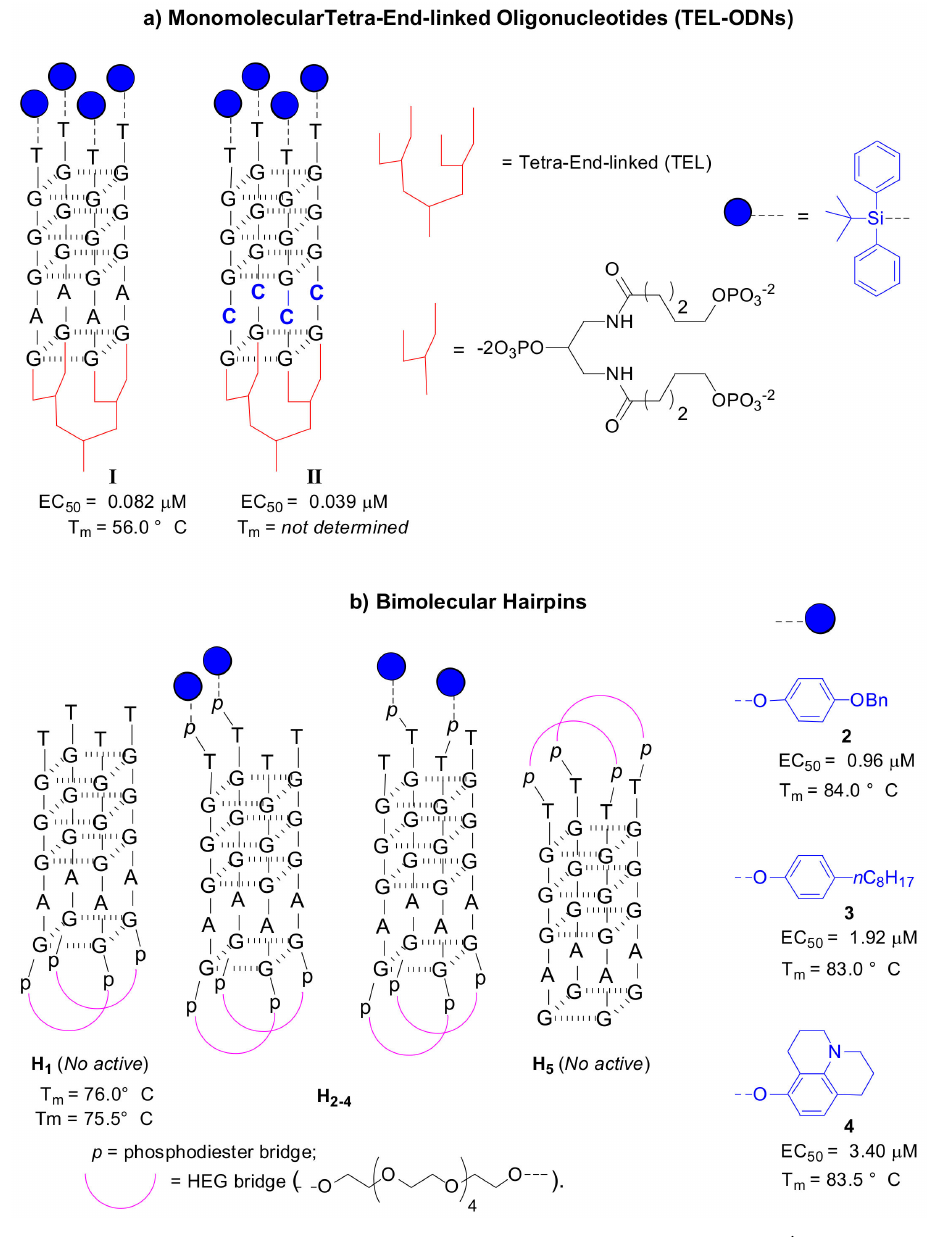
Figure 4. ( a ) G-quadruplex structures of monomolecular TEL-ODNs modified at 5 (cid:48) -end with TBDPS group ( I ) and the both 5 (cid:48) -end and internal modified TEL-G4 ( II ) with a cytosine that replaces the adenosine base of the Hotoda’s sequence [41,42], ( b ) Bimolecular G-quadruplex Hairpins with related anti-HIV activity (EC 50 ) and thermal stability (T m )